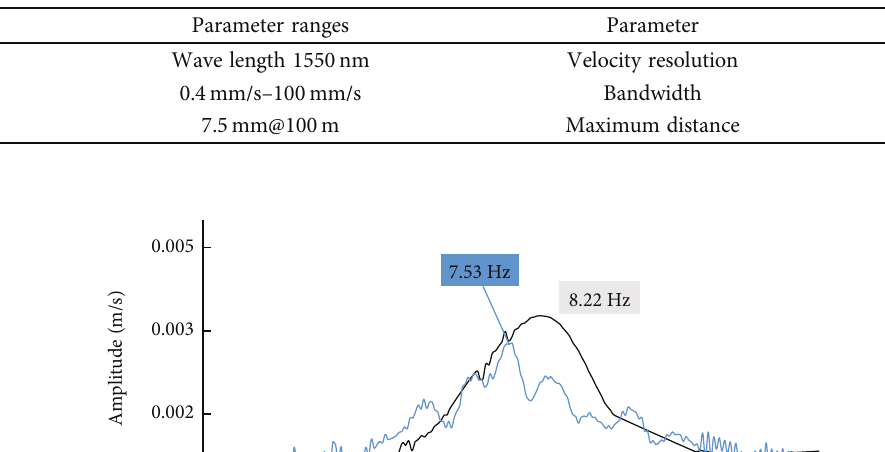
Table 1: Technical parameters of RSV-150 remote laser vibrometer.